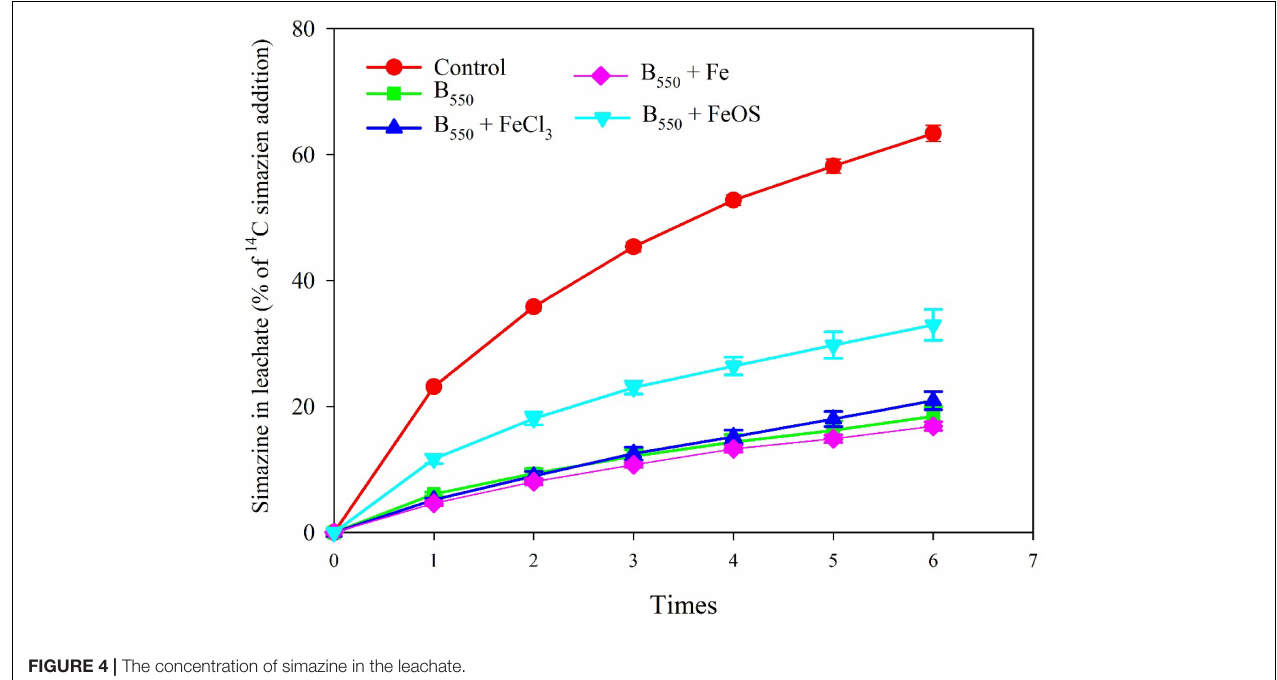
FIGURE 4 | The concentration of simazine in the leachate.